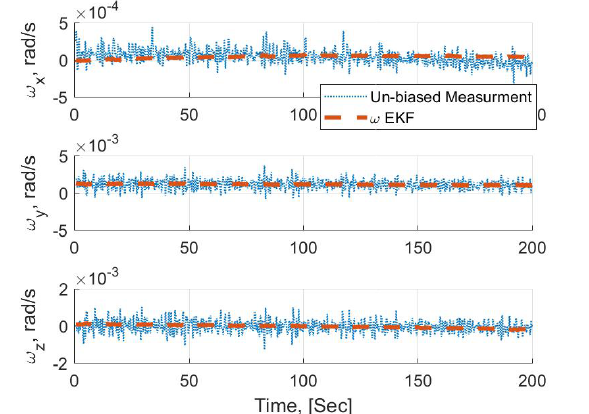
Figure 15. Angular velocities history from unbiased gyroscope measurements and the EKF output for 1st